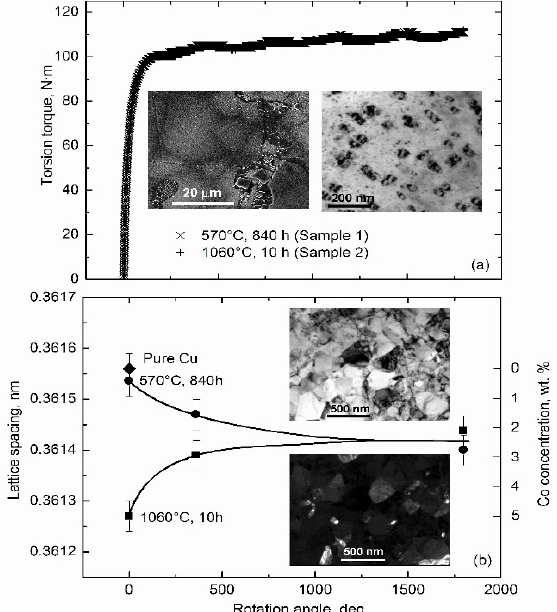
Figure 4. ( a ) Dependence of torsion torque on the HPT anvil rotation angle. The scanning electron microscopy (SEM, left ) and transmission electron microscopy (TEM, right ) micrographs in the insets are for the Cu–4.9 wt.% Co alloy after annealing at 570 ◦ C for 840 h. ( b ) Dependence of lattice period on the HPT anvil rotation angle. Diamond shows the lattice period for pure copper. Circles mark the lattice period in sample annealed at 570 ◦ C for 840 h. Squares correspond to the sample annealed at 1060 ◦ C for 10 h. The respective cobalt concentration is shown on the right vertical axis, c eq ≈ 2.5 wt.% Co. Insets: Bright-field ( top ) and dark-field ( bottom ) TEM micrographs of Cu–4.9 wt.% Co alloy after annealing at 570 ◦ C for 840 h and HPT (6 GPa, 5 rot, 1 rpm). Reprinted with permission from ref. [2]. Copyright 2014